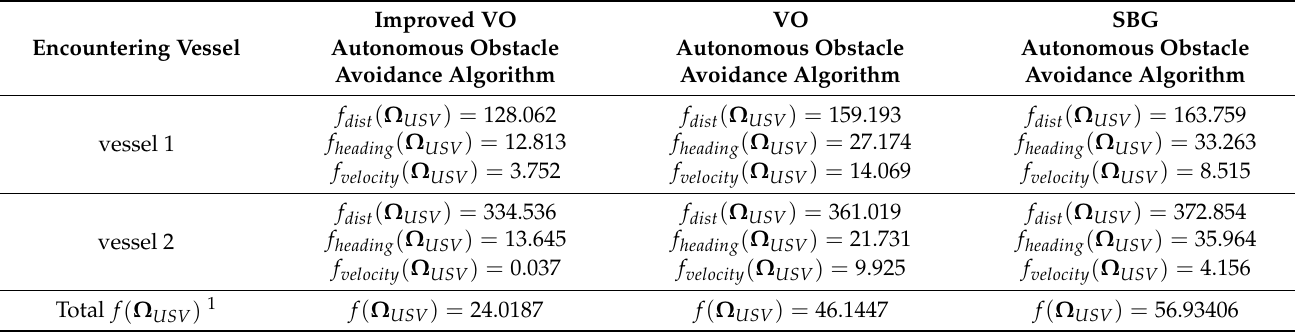
Table 11. Comparison results of three algorithm performance